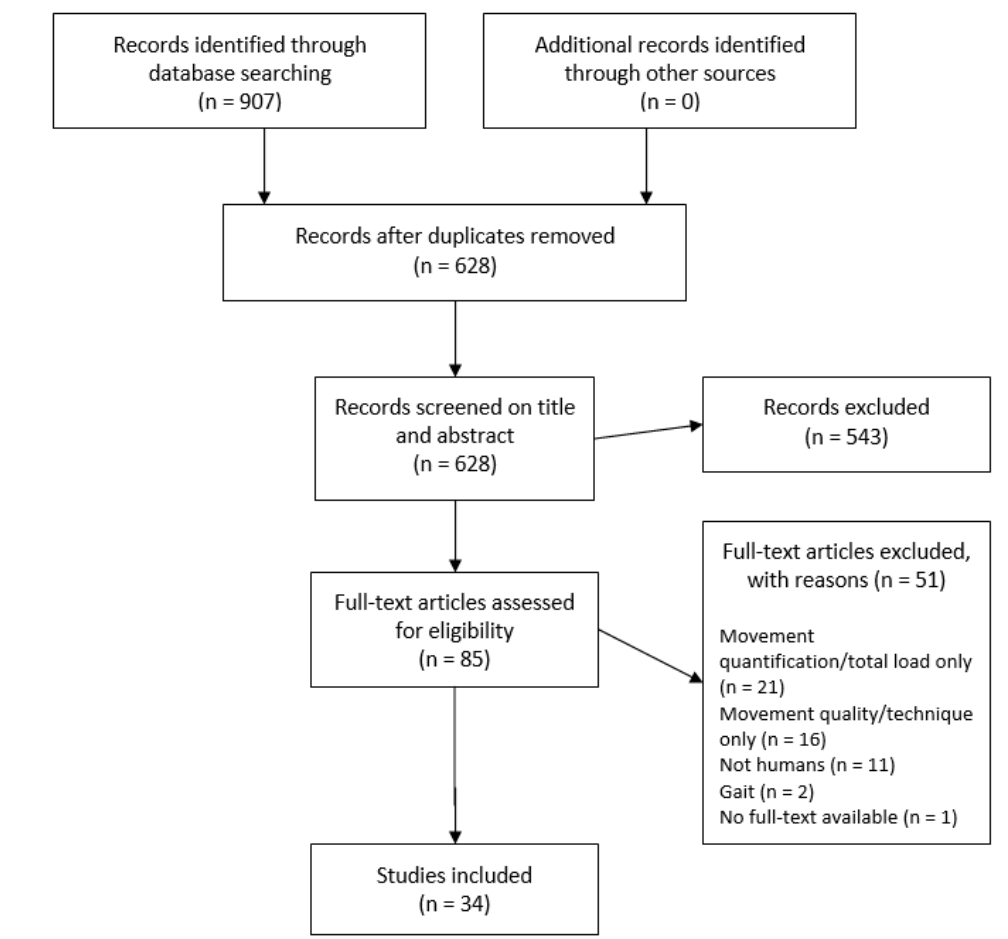
Figure 1. Flow diagram of selection of sources of evidence.